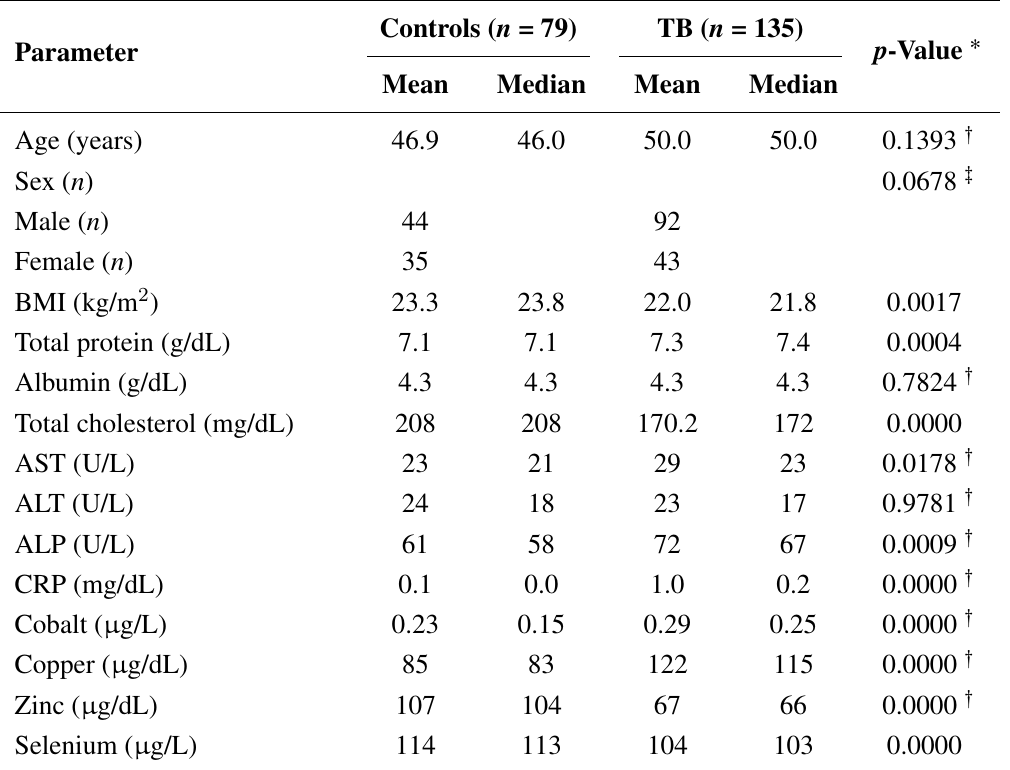
Table 3. Comparison of demographic characteristics and trace element concentrations of pulmonary tuberculosis patients ( n = 135) and the control group without pulmonary tuberculosis ( n =